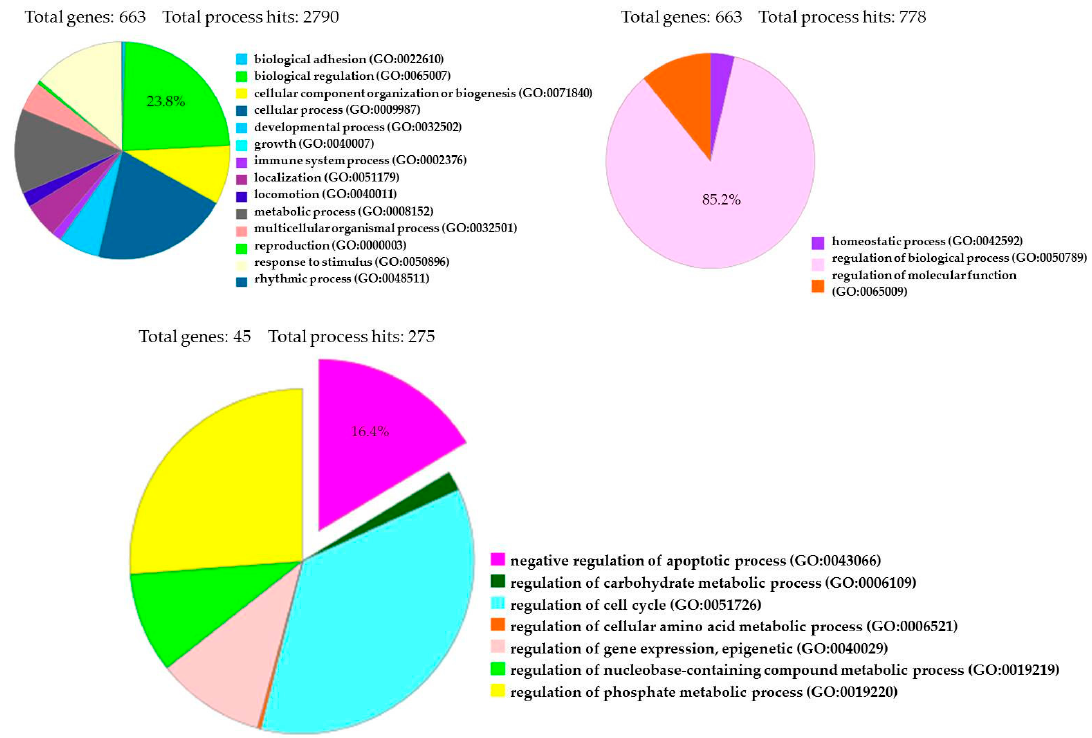
Figure 4. Gene Ontology Analysis of 6843 genes differentially expressed between treated hPDLSCs (MOR+CBD) and untreated cells (CTR).